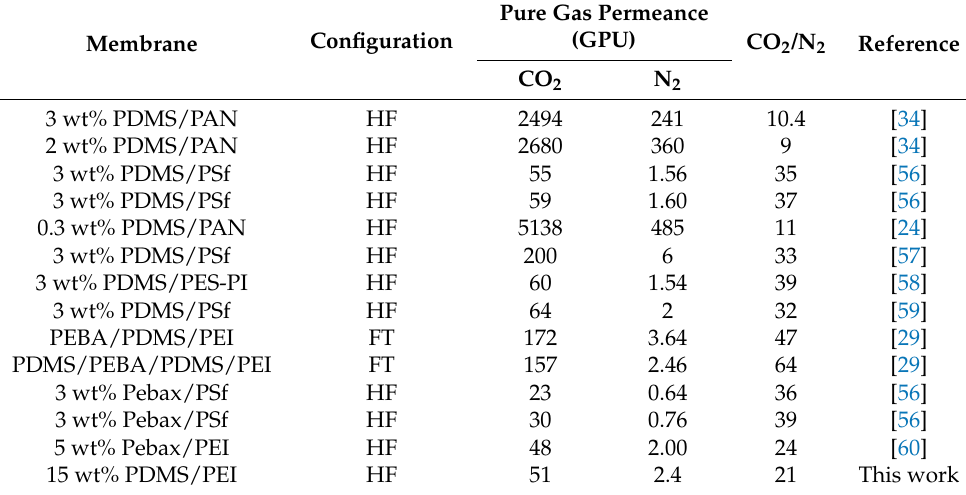
Table 3. Comparison of the thin film composite hollow-fiber membranes for CO 2 /N 2 separation (HF—hollow fiber and FT—flat sheet).